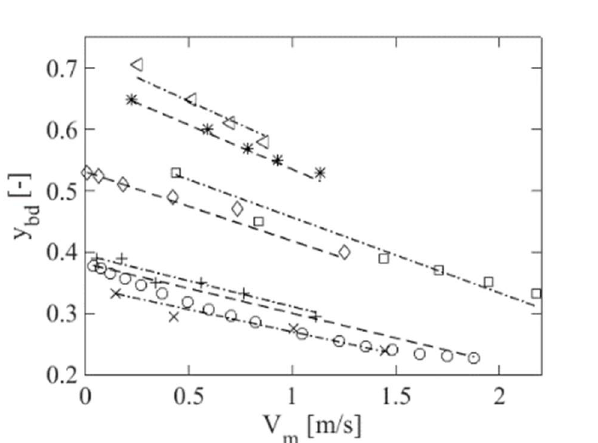
Fig. 3. Sliding bed layer thickness expressed as a function of initial thickness of the bed and mean velocity of the flow .